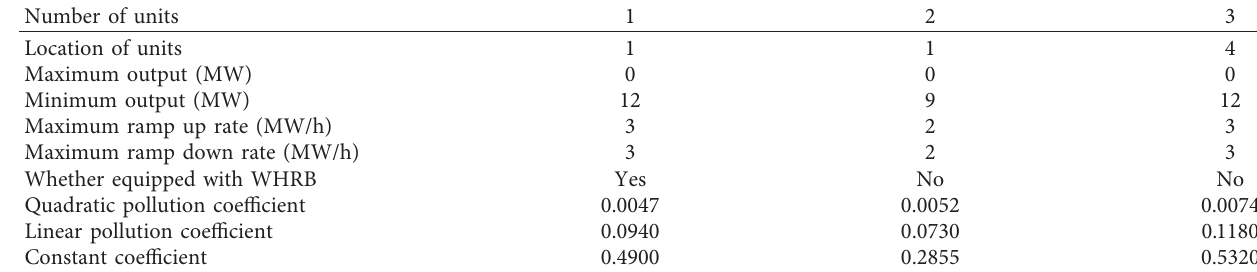
Table 1: Parameters related to GTs